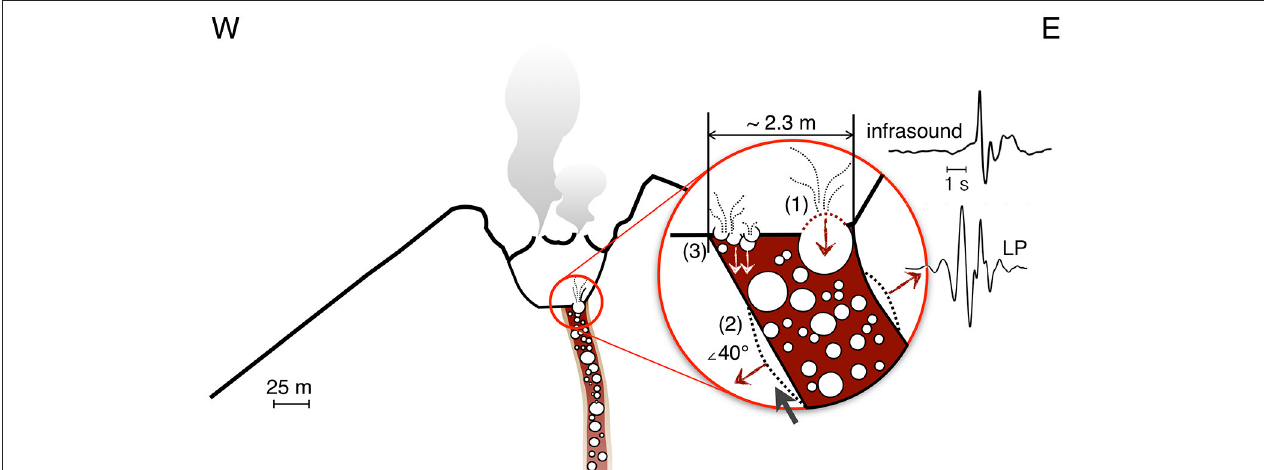
FIGURE 10 | Schematic of the proposed interpretations of the source-time function of the small long-period events recorded at Pacaya: (1) LPs seen as a manifestation of the reaction force to the expansion and ejection of the bubbles; (2) LPs seen as originating from the movement of the bubbles through an inclined crack that inflates and deflates as a result of the passage of fluids; (3) LPs seen as the results of bubbles that act as a volumetric source exploding at the surface with a sudden release in pressure.